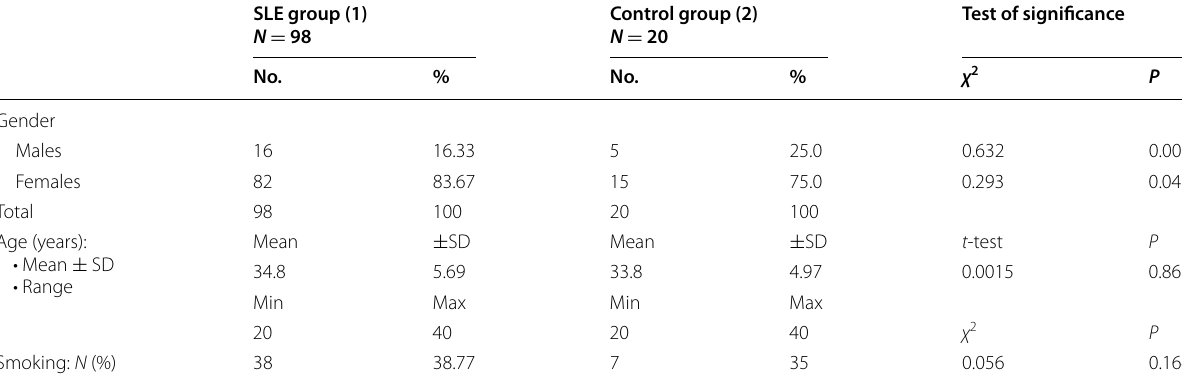
Table 2 Demographic characteristics of the studied